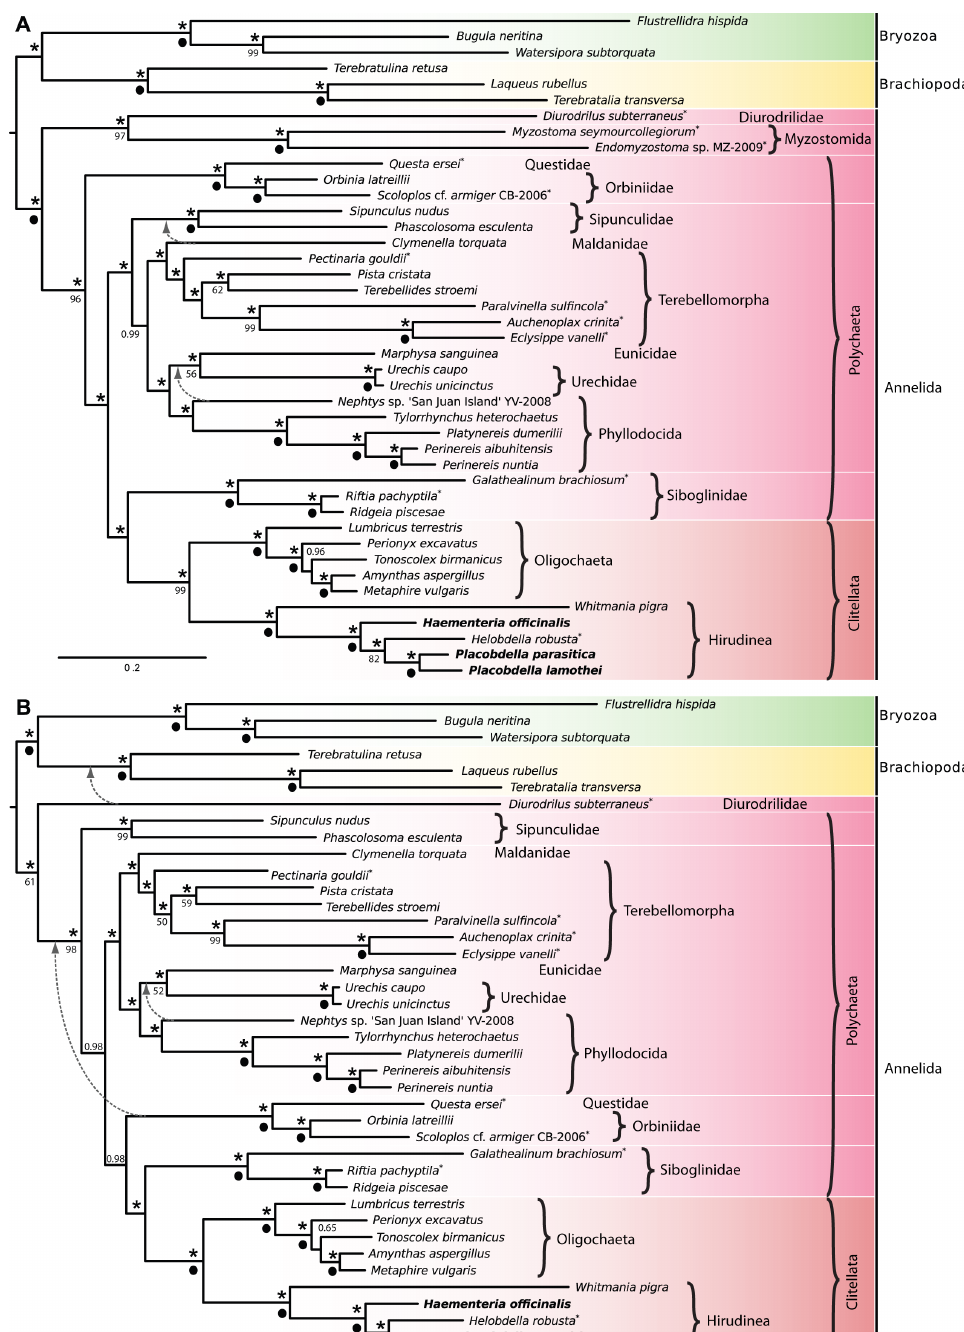
Fig 3. Phylogenetic relationships of Annelida. Bayesian phylogenetic reconstruction as inferred by MrBayes with Myzostomida included, A, and excluded, B. Values above nodes are Bayesian posterior probabilities, and those below the nodes are parsimony bootstrap support values above 50%; asterisks denote maximum posterior probabilities and black circles denote maximum parsimony bootstrap support. Taxa in bold were sequenced for the present study and broken lines indicate the alternative positioning of the respective taxa in the single most parsimonious trees.